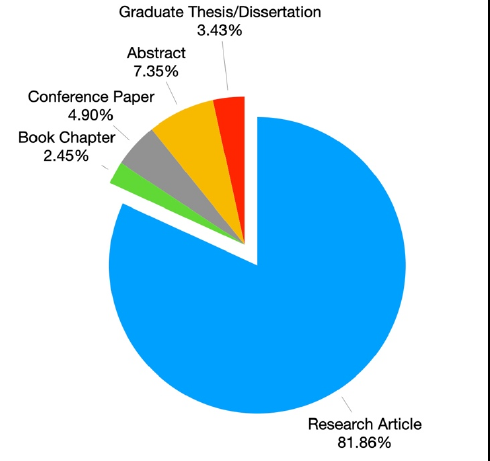
Figure 3. Frequency distribution of article types (Sum of percentages is not equal to 100% due to rounding).